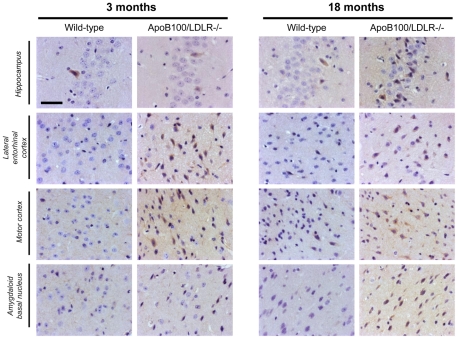
MAP2 staining in young and aged wild-type and transgenic mice.MAP2 staining of coronal sections (1.78 mm from the bregma) of the left (contralateral) hemisphere of a mouse brain from each of the age/genotype groups. Hippocampus and three areas of the cortex showing several nuclei of the temporal lobe cortex, such as the lateral entorhinal, ectorhinal, perirhinal and temporal-association cortices, the primary and secondary somatosensory cortices, lateral parietal association cortex and visual cortex, and the cortical amygdaloidal nucleus and amygdalohippocampal area. Scale bar: 25 µm.